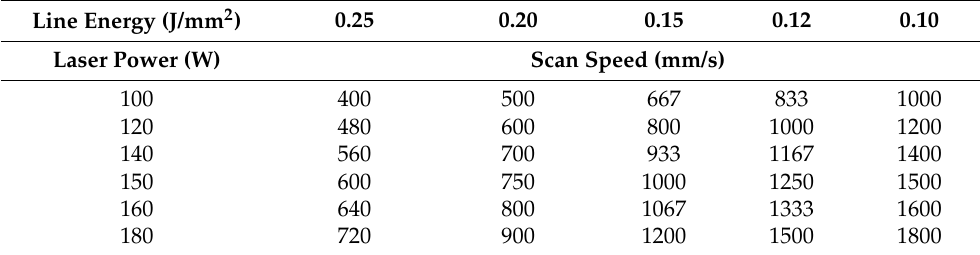
Table 1. Parameter sets used for the line